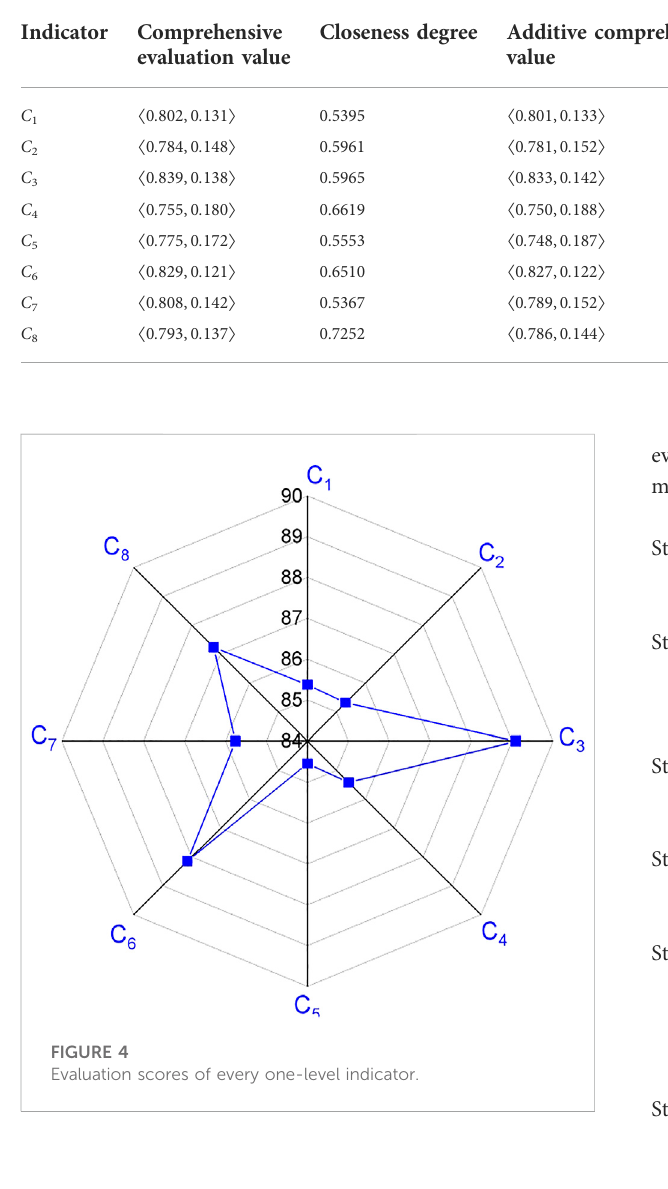
indicator can be transformed into the IF number obtained in Step 5 from Eq. 13, which is shown in Figure 4: As shown in Figure 4, the evaluation scores of every one-level indicator C 1 -C 8 are 85.37, 85.32, 89.09, 85.42, 84.54, 88.15, 85.76, and 87.24. In summary, the performance evaluation scores and grades for each level of the performance indicator are shown in Table 5. From Table 5, the performance evaluation results of the eight two-level indicators are good. Combining the corresponding weights of every one-level indicator in Table 4, the fi nal performance evaluation score of the water environment treatment and ecological restoration projects in the county was 86.60 (the evaluation grade is good), which indicates that all evaluated items in the operation of the project were conducted smoothly. Speci fi cally, the operation of the SPV company is